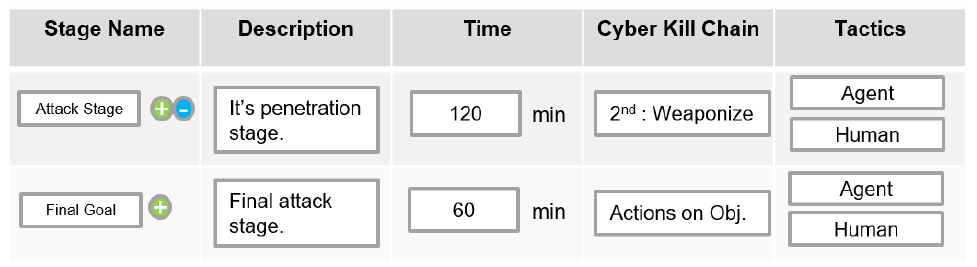
Figure 10. Phase generation function.